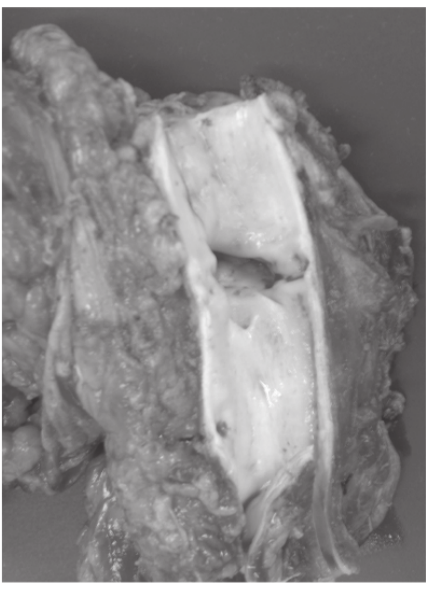
Figure 3 - Fragment from the tumoral bloc showing a segment of the aorta with wall erosion.